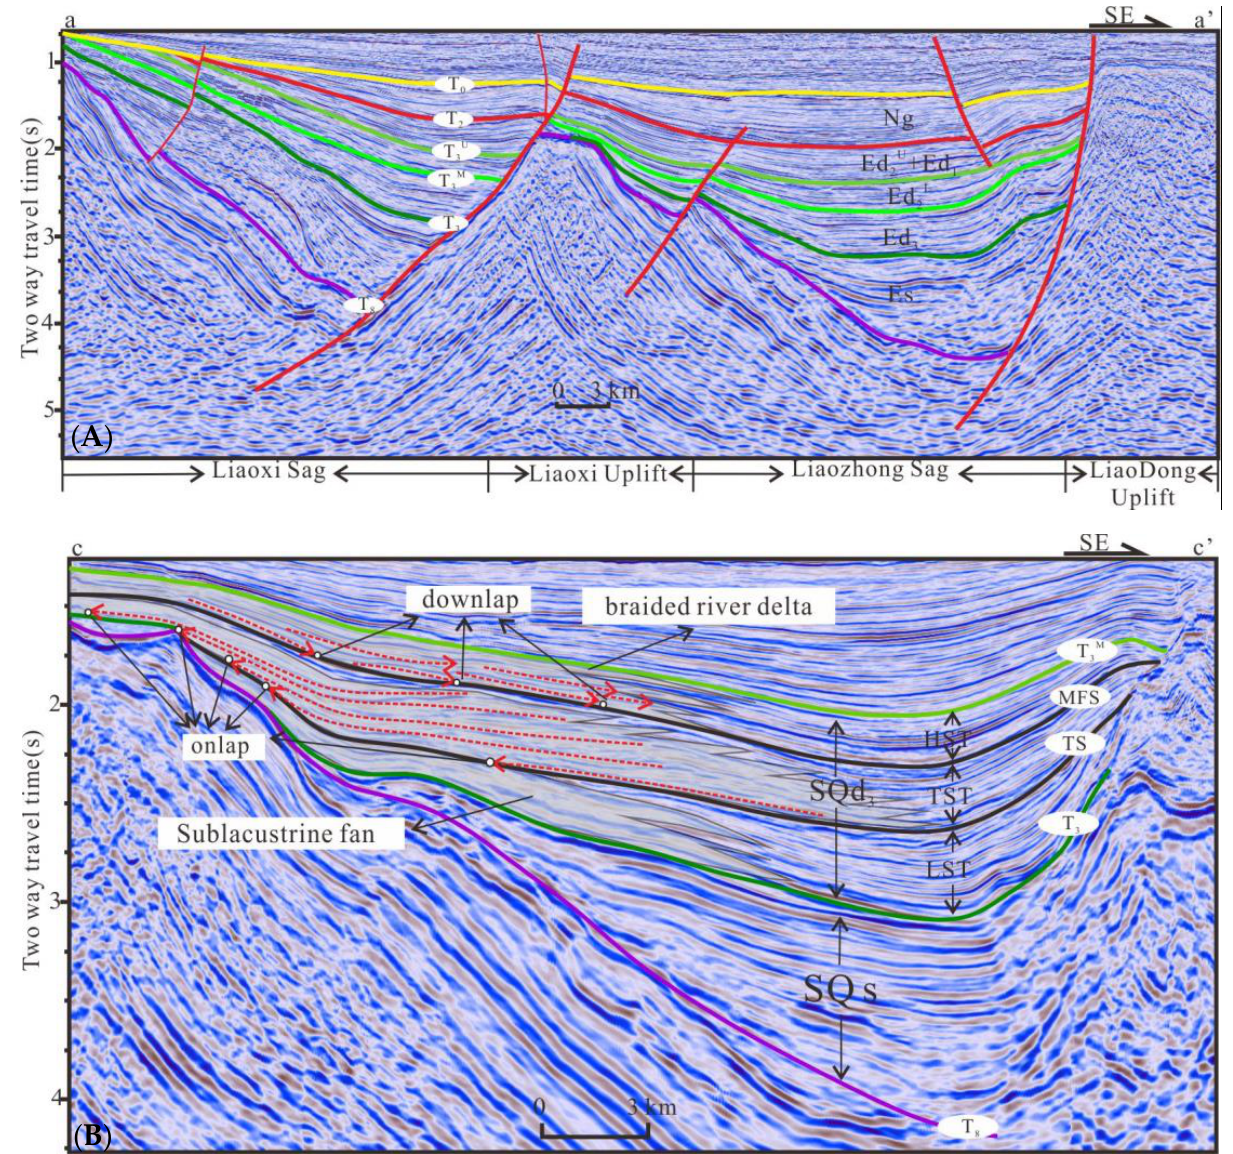
Figure 2. ( A ) Seismic section and structural units of Paleogene strata in Liaodong Bay Depression. ( B ) Seismic section and sequence boundaries of the SQd 3 . Annotation: a-a’ and c-c’ are the numbers of seismic section. Figure 1C shows locations.